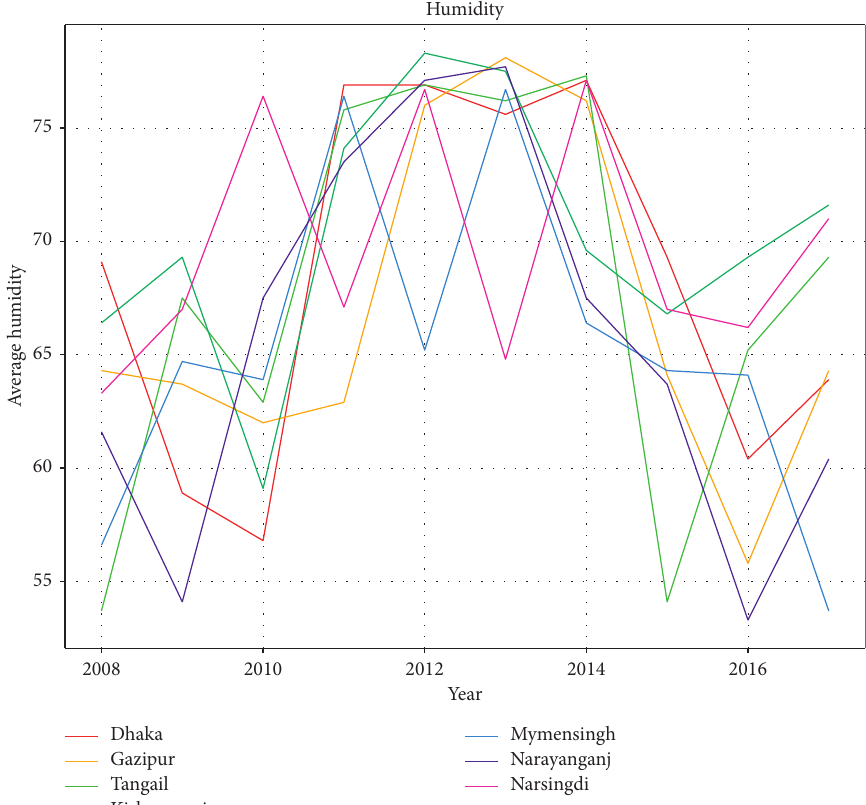
Figure 4: Analysis of average